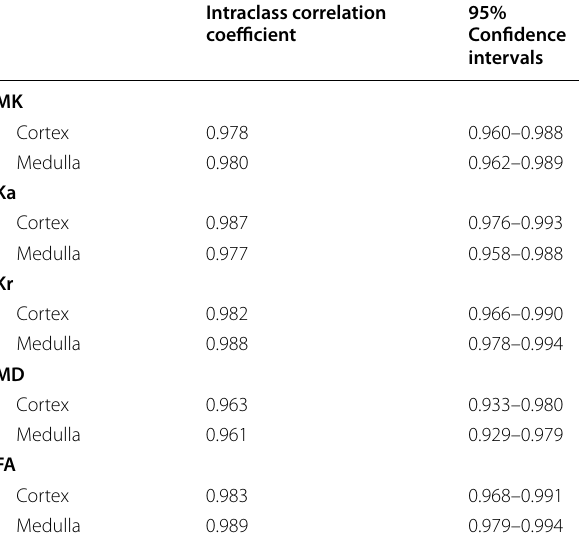
MK, parenchymal Kr or cortical FA between patients